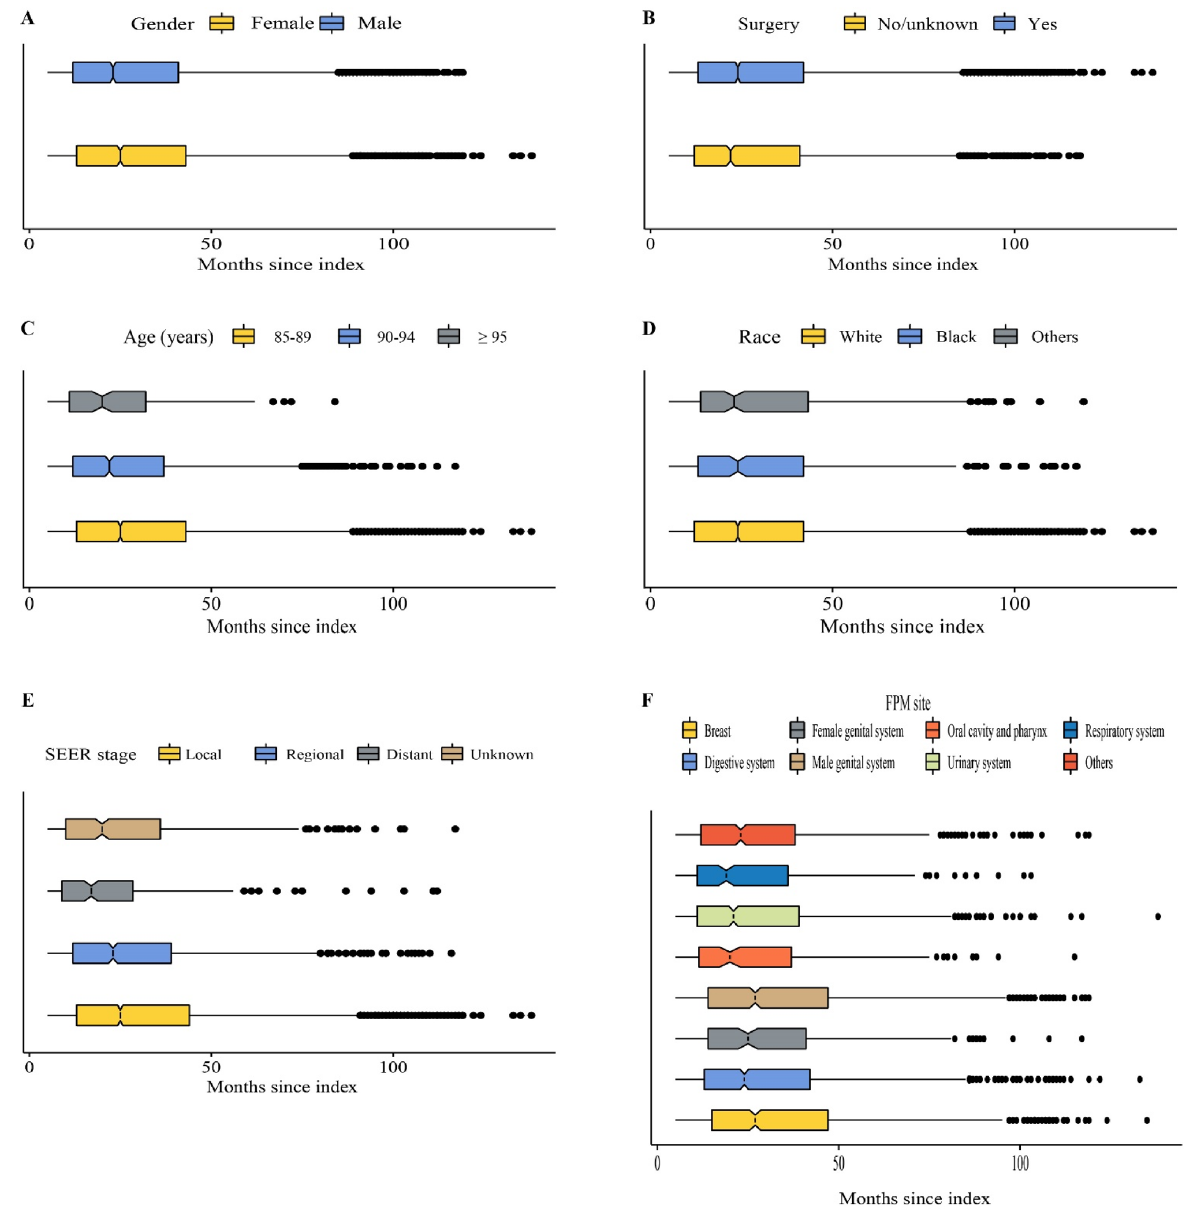
Figure 3. Time interval since index stratified by ( A ) gender, ( B ) surgery history, ( C ) age, ( D ) race, ( E ) SEER stage, and ( F ) FPM site. SEER surveillance, epidemiology, and end results; FPM first primary